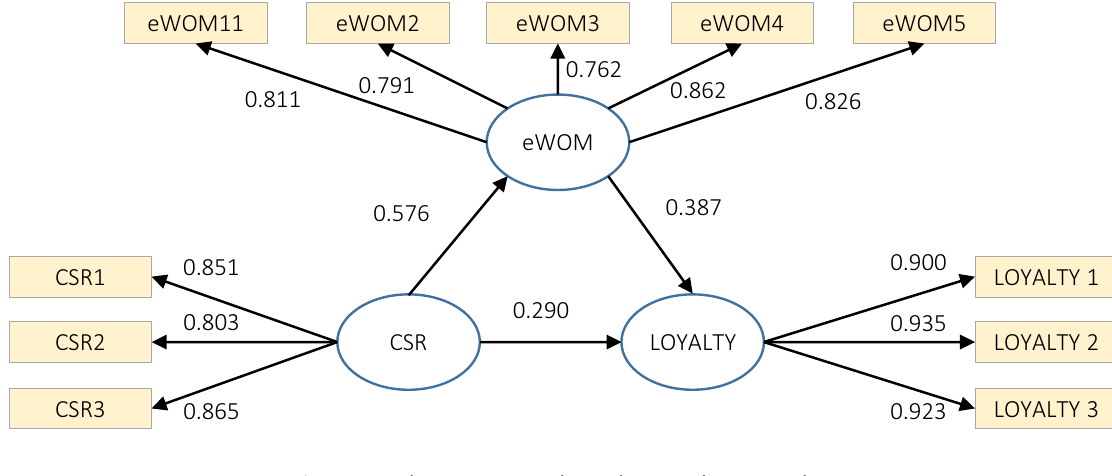
Figure 2. The PLS-SEM algorithm analysis results Table 3. PLS-SEM algorithm analysis results